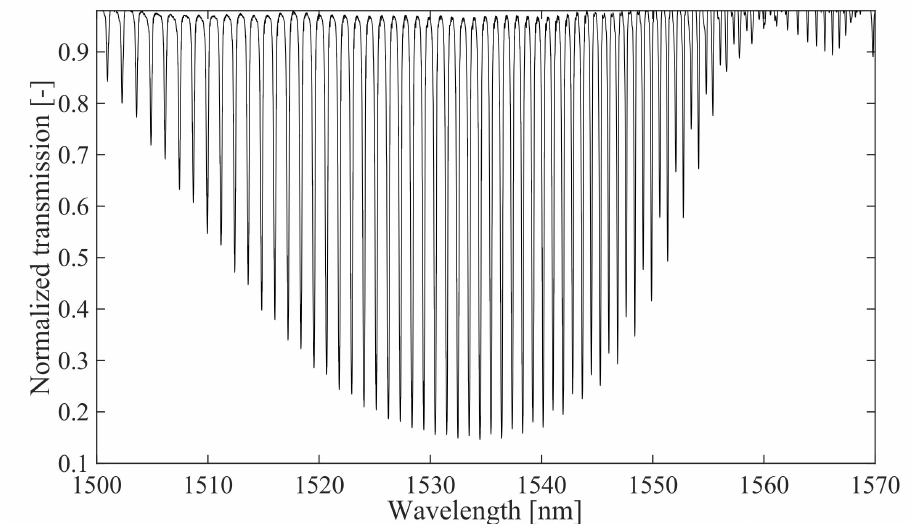
Figure 6. Spectral characteristics of the TFBG structure: θ = 5 ◦ , φ = 0 ◦